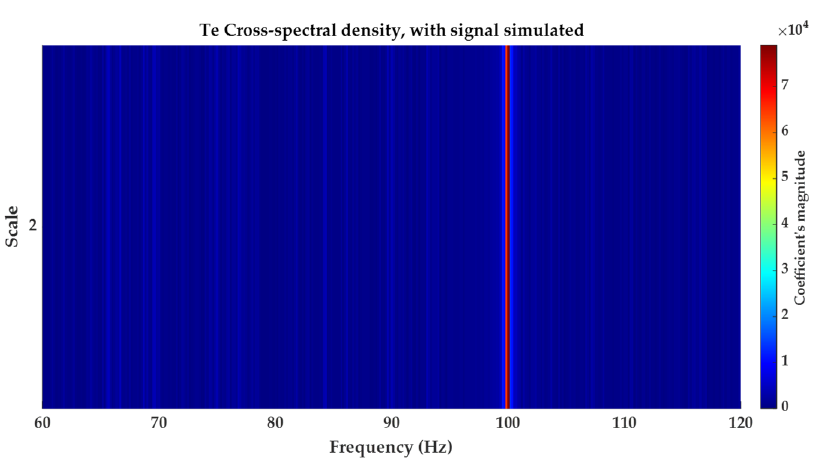
Figure 4. T e cross-spectral density, with two synthetic signals: S 1 = sin ( 2 π 10 t ) + sin ( 2 π 100 t ) and S 1 = sin ( 2 π 50 t ) + sin ( 2 π 100 t ) .